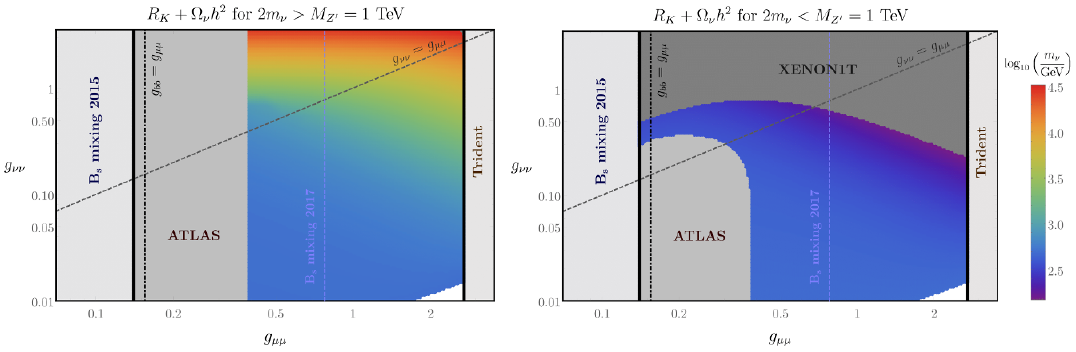
Figure 9 . Summary of the constraints for M Z 0 = 1 TeV. See text in section 5 for details.